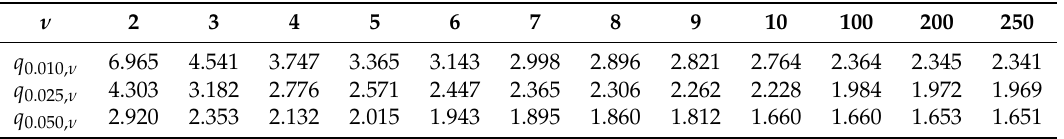
Table A1. Accurate numerical values of q α , ν for different α and ν in the case of multivariate Student t . The table reproduces numerical values of q α , ν for different α and ν of interest as tabulated in [6] (Section 2.2) for the purposes of computing expected